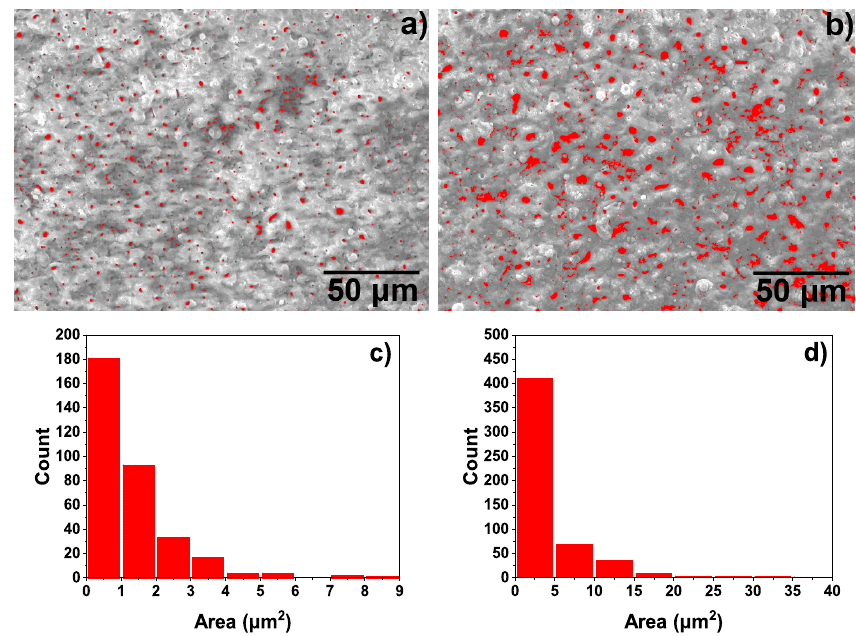
Figure 6. Image analysis results of the distribution and sizes of the holes in the MAO ceramic layer of